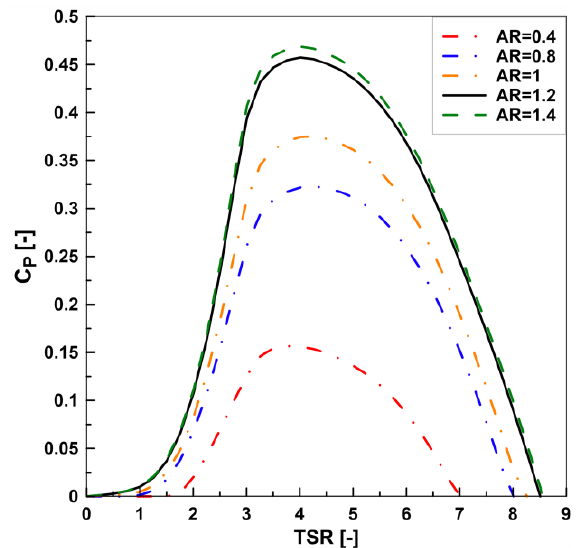
ff ect of increasing the AR on the rotor’s power coe ffi Figure 14. Effect of increasing the AR on the rotor’s power coefficient. Figure 14. E